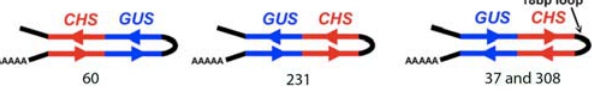
Figure 1. Inverted repeat (hairpin) structure of the expected RNAs produced by CHS transgenic A. thaliana lines. The corresponding gene constructs differ in the position and orientation (indicated by the arrow) of the fragments (CHS and GUS) within the hairpins (modified from Wroblewski et al. 2007-submitted). The transgenic line numbers are indicated below the corresponding